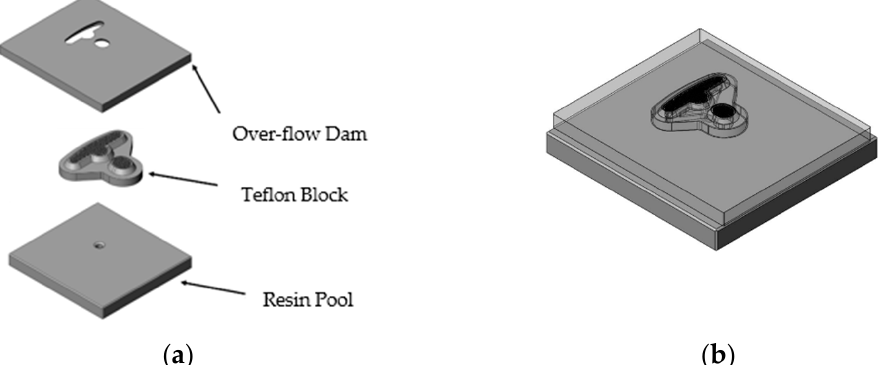
Figure 4. Runner design. ( a ) The individual design of the over-flow dam, the Teflon block, and the resin pool and ( b ) the overall design of the runner.